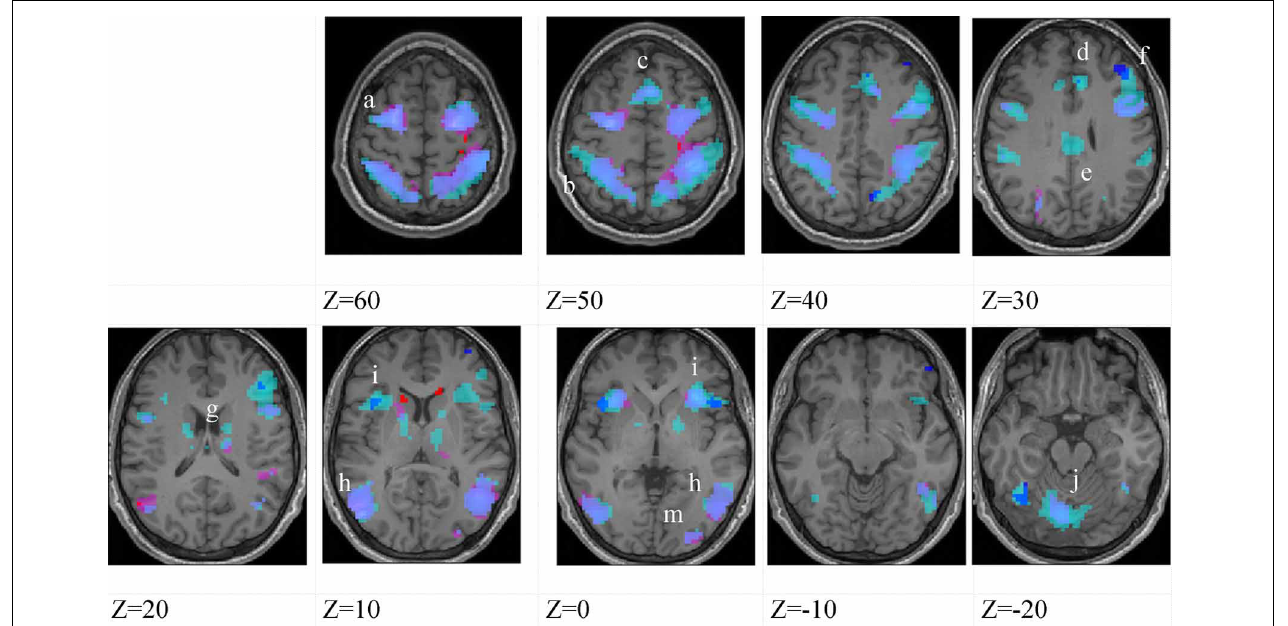
FIGURE 3 | Higher-skilled males. Second-level fMRI activations ( p < 0 . 005, FWE corrected, 25 voxels minimum cluster size) to deception identification (cyan) and direction identification (magenta) in point-light soccer video clips, relative to stimulus-matched non-biological motion (NBM) controls. Overlapping areas responding to both identification tasks appear purple. Activations above threshold (blobs) are displayed in co-registration with an individual normalized structural brain image and sampled in horizontal sections 10mm apart from z = 60 to z = − 20. In